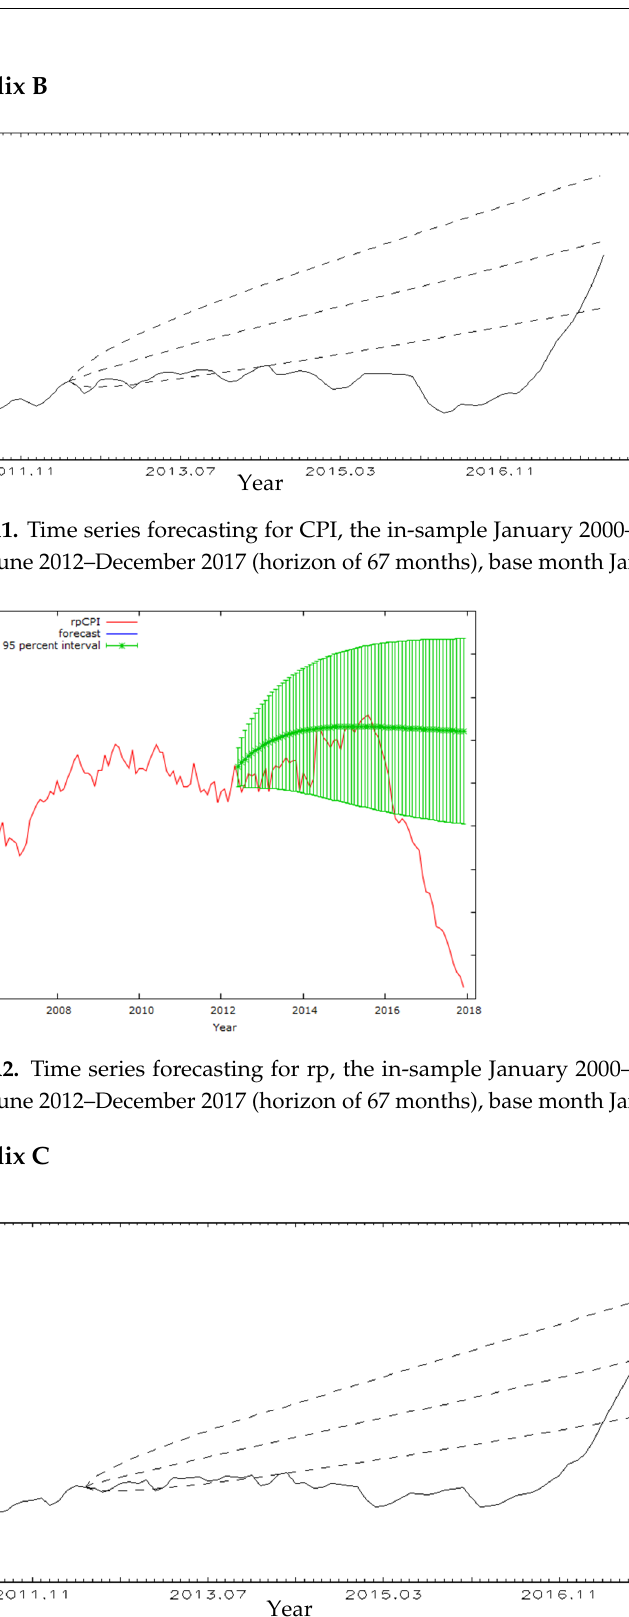
Figure A4. Time series forecasting for dpea, the in-sample January 2000–May 2012, and the out-of- sample June 2012–December 2017, base month January 2000 = 100. Appendix D Figure A5. Time series forecasting for IPHIEA, the in-sample January 2000–May 2012, and the out- of-sample June 2012–December 2017, base month January 2000 = 100.